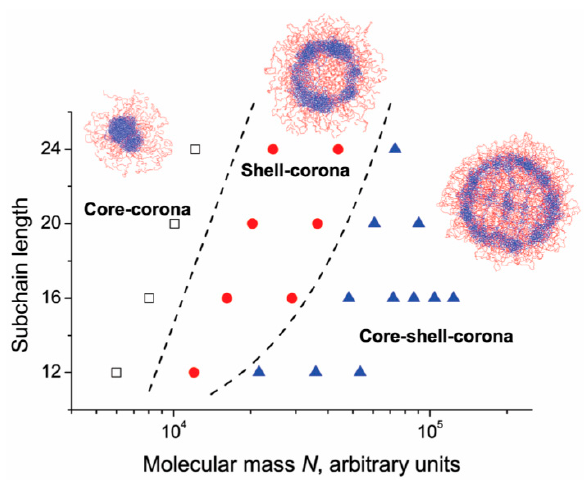
Figure 4. Interpenetrating polymer networks (IPN) microgel structure as a function of molecular mass and subchain length. Adapted from Rudyak and coworkers [86], Copyright 2018 Royal Society of Chemistry.